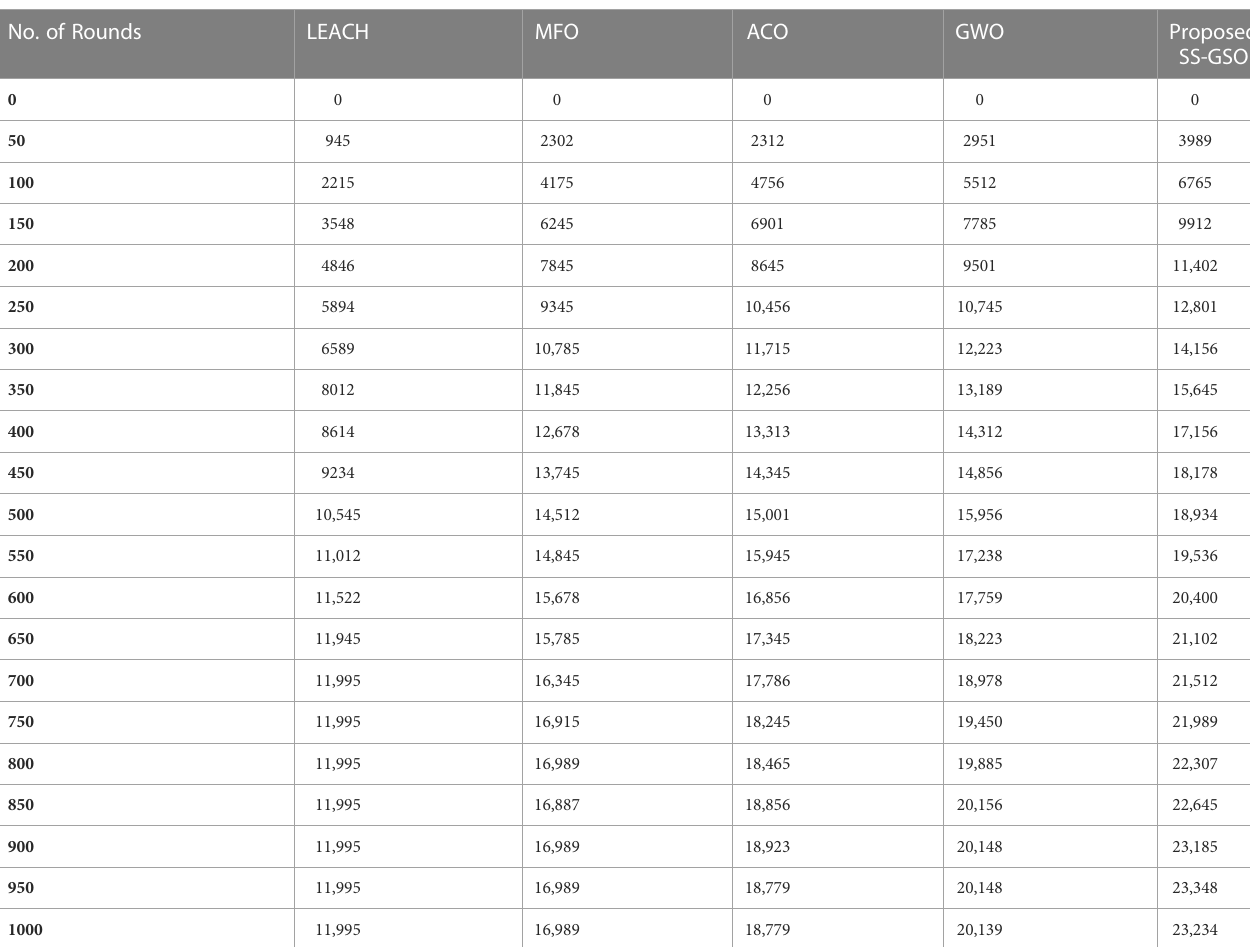
TABLE 4 Number of packets received analysis.